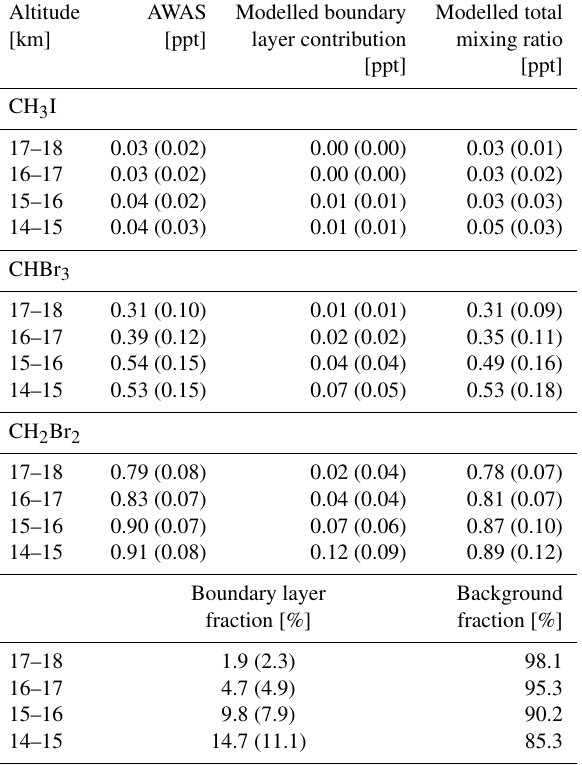
Table 4. ATTREX 2013 all flights. AWAS observations; modelled boundary layer contribution; and the modelled total mixing ratios for CH 3 I, CHBr 3 , and CH 2 Br 2 . The boundary layer and back- ground fractions are also given. Means and standard deviations are given in